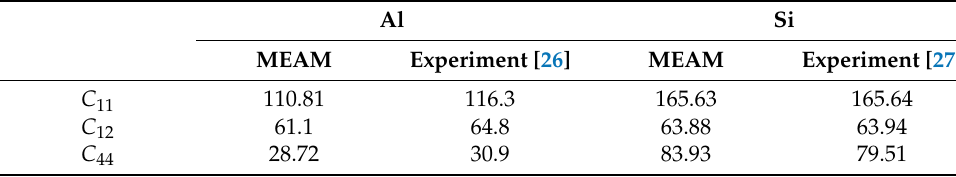
Table 1. Elastic constants of Al and Si. The SI unit of the elastic constant C ij is GPa. Al